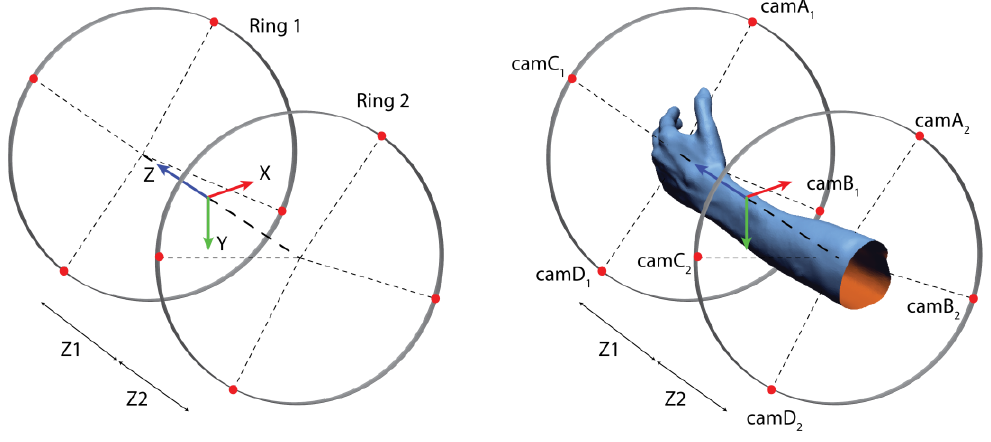
Figure 11. Optical sensors reference frame and Figure 11 . Optical sensors reference frame and coordinates.